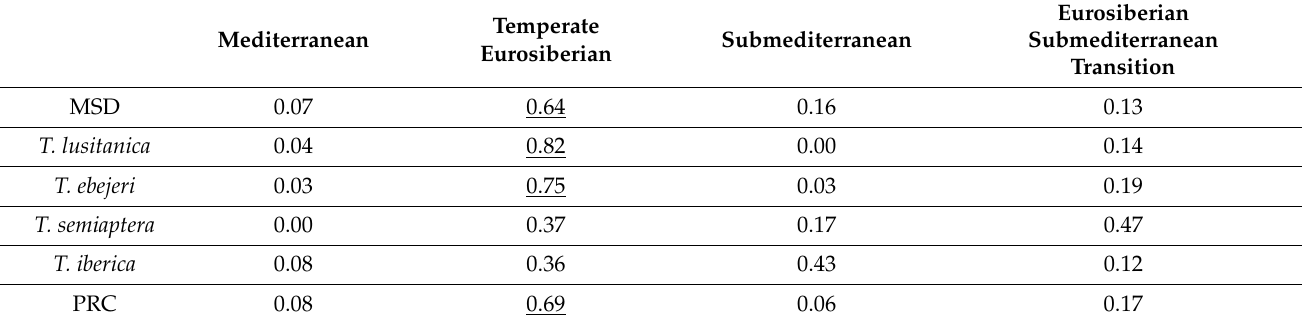
Table 5. Species distribution overlap: area intersected with Life zones/total area target